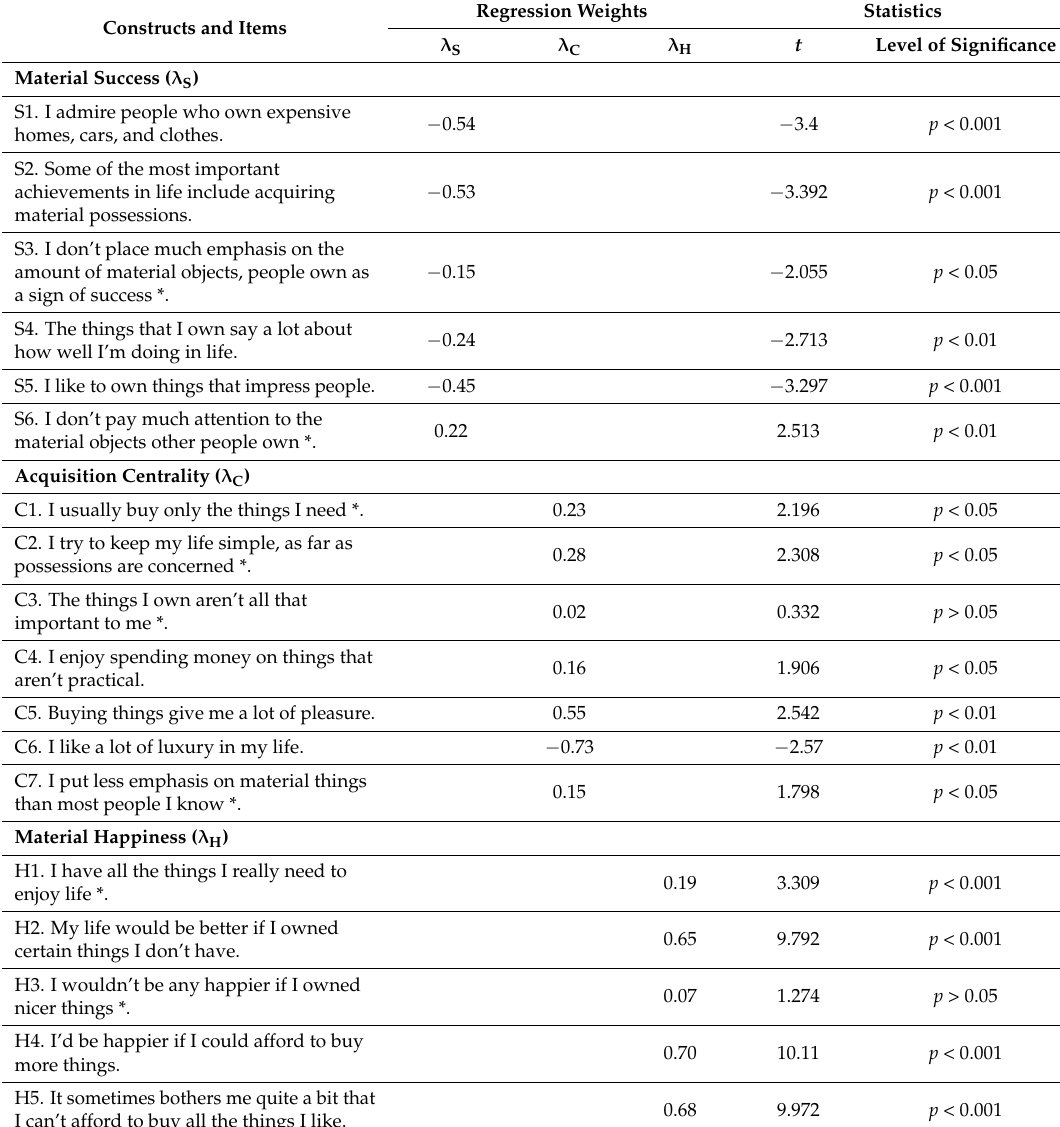
Table 1. Constructs, items and standardized regression weights for materialism scale.